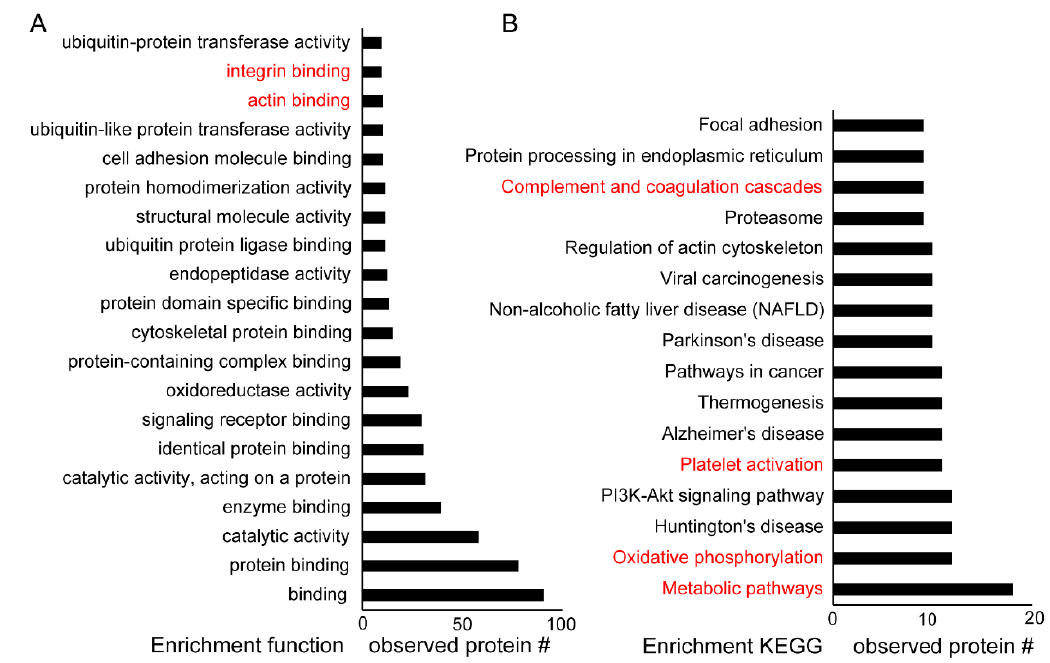
Figure 4. Enriched function (GO) and KEGG analysis of identified proteins. STRING (functional protein association networks) used in the grouping of identified proteins. ( A ) Top 20 enriched functions of Parkin-interacting proteins in human DM platelets. ( B ) Top 16 enriched KEGG pathways of Parkin-interacting proteins in human DM platelets.